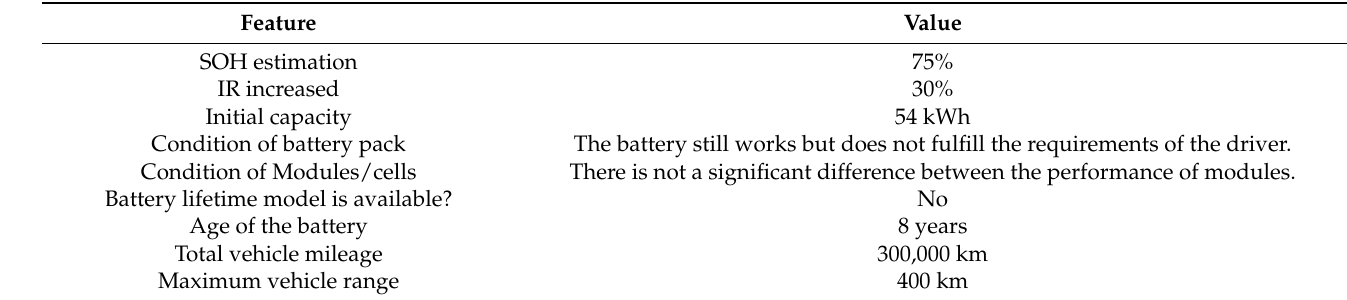
Table 5. Information available for assessing the condition of the